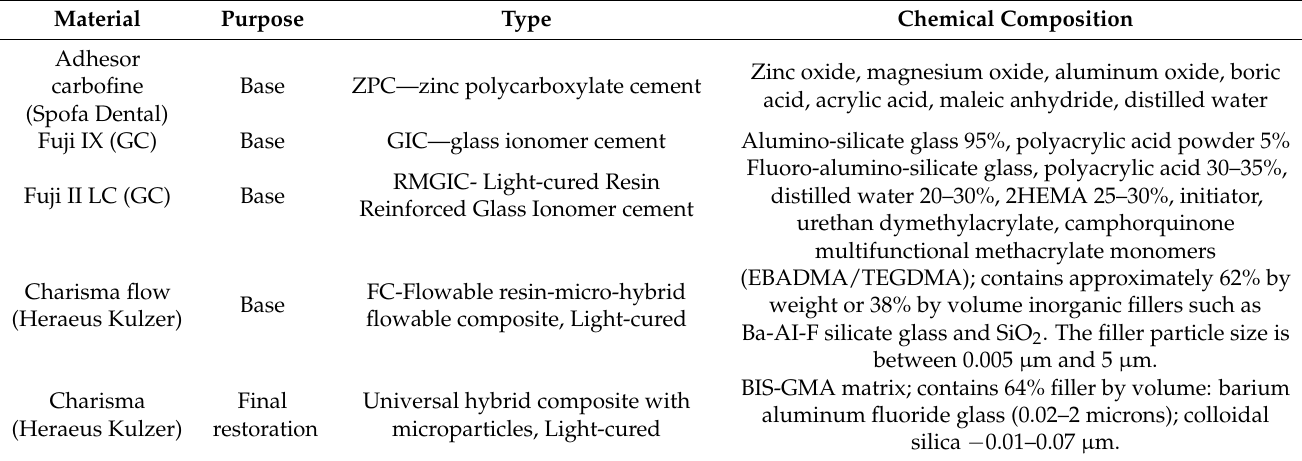
Figure 1. ( a ) Group of six molars unprepared; ( b ) group of six molars with MOD cavities; ( c ) group of samples prepared for testing; ( d ) universal loading machine; and ( e ) specimen before testing. Table 2. The materials used for teeth